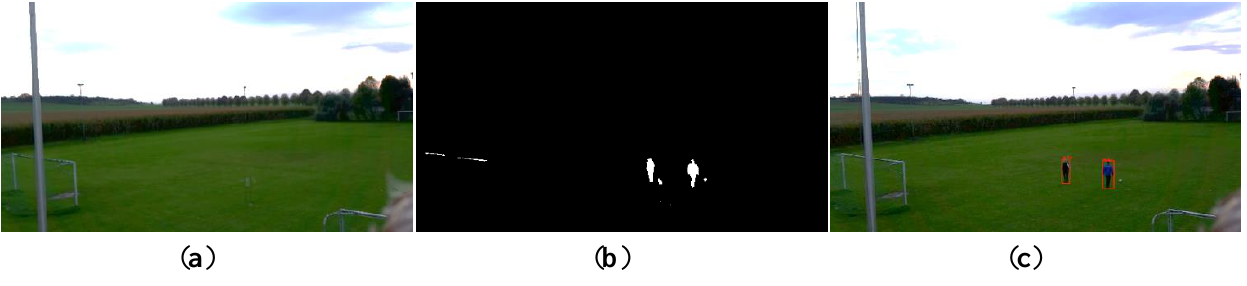
Figure 2. ( a ) The background image of the observed scene. ( b ) The detected changes. ( c ) The resulting object detections framed by red bounding boxes.